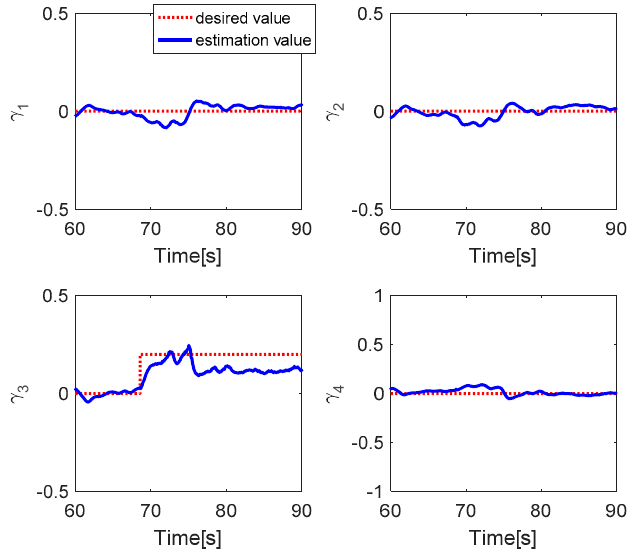
Figure 6. Fault estimation of each actuator.